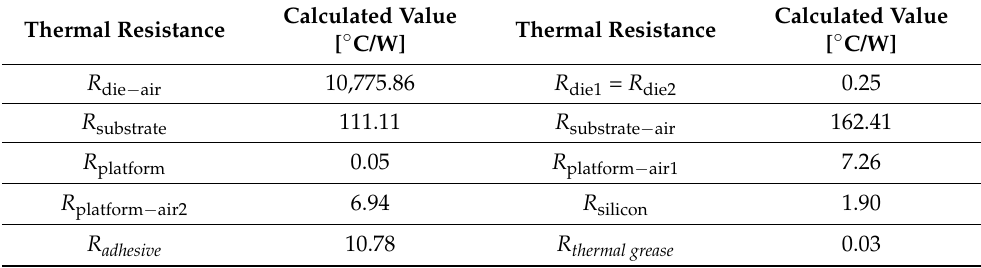
Table 1. Calculated values of thermal resistance of each part of the